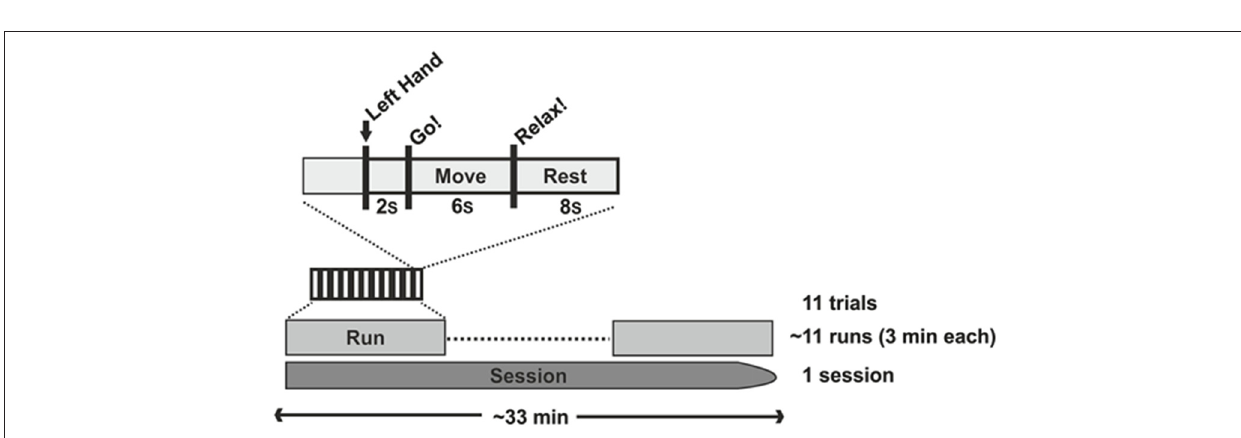
FIGURE 2 | Study design .